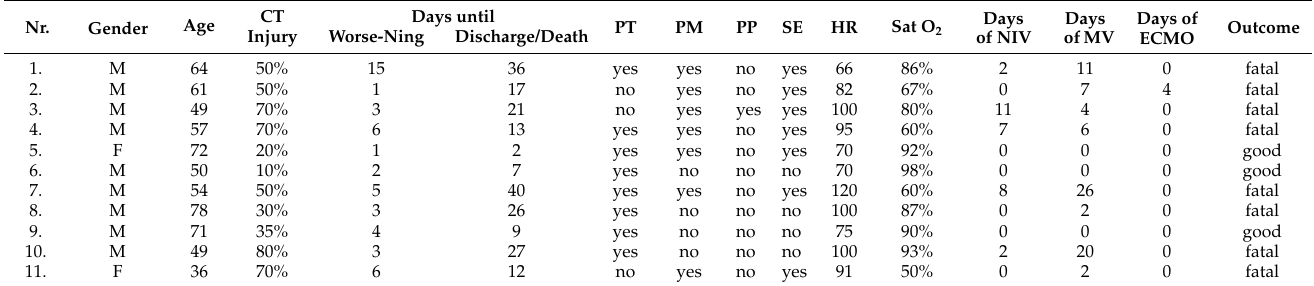
Table 1. Characteristics of the patients group.